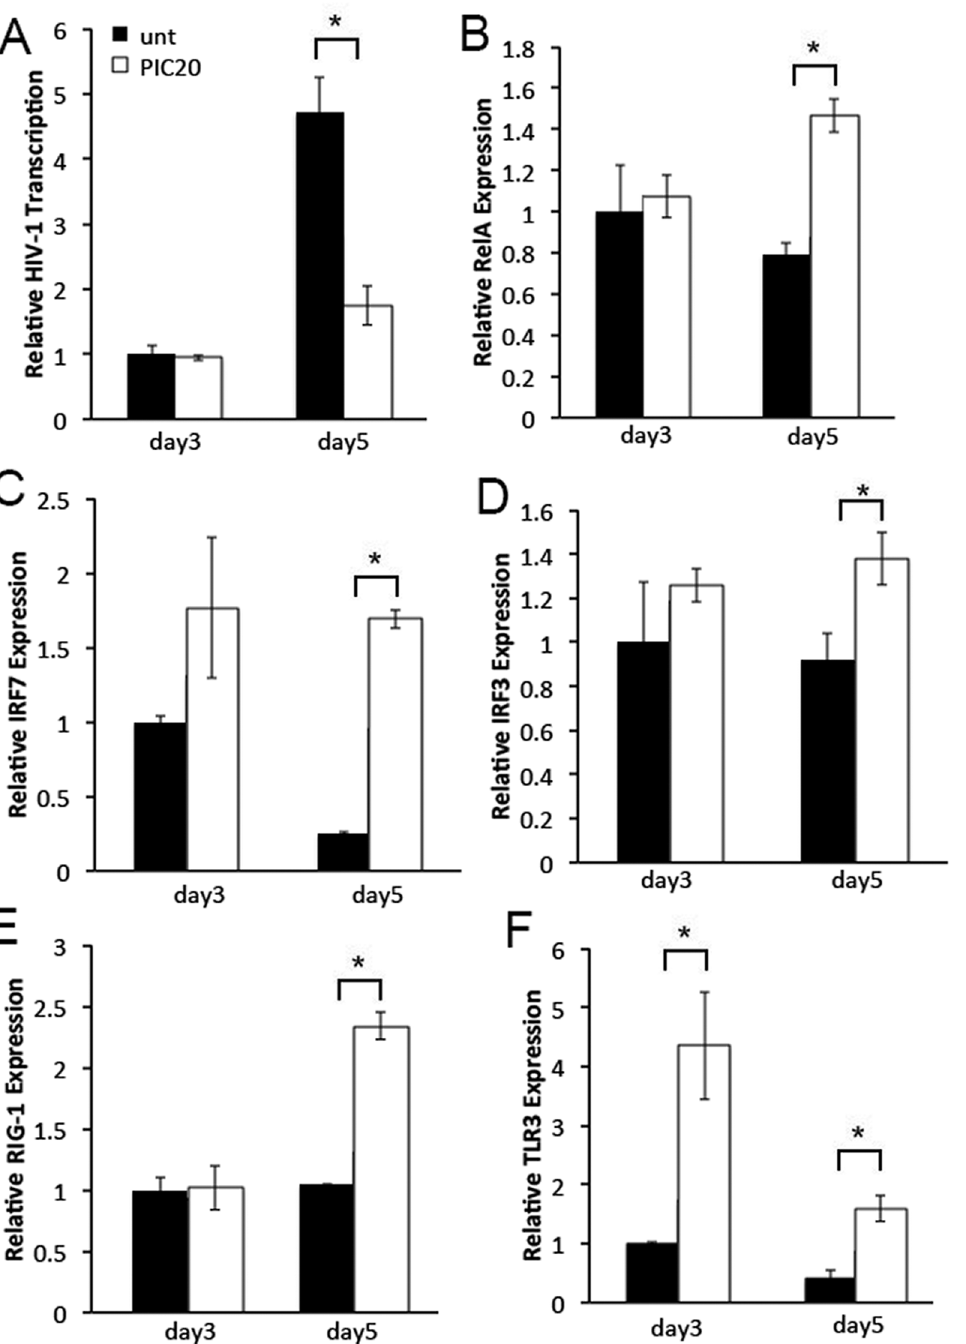
Fig 3. Poly (I:C) decreases HIV-1 transcription by increasing IRF7 expression in PBMCs. (A) Levels of HIV-1, (B) RelA, (C) IRF7, (D) IRF3, (E) RIG-1, and (F) TLR3 transcription in HIV-1 infected PBMCs left untreated or treated with poly (I:C) at 20 μ g/ml were quantified by RT-PCR on days 3 and 5 after infection. All data was normalized to GAPDH. For each gene, day 3 values in untreated control tissues were set to 1. Day 5 values in untreated control tissues or days 3 and 5 values in poly (I:C) treated tissues were normalized to 1. Results were consistent among three donors and are shown as the mean ± STDEV from one representative experiments with each condition tested in triplicate. * p < 0.05 for untreated and poly (I:C) treated cells.